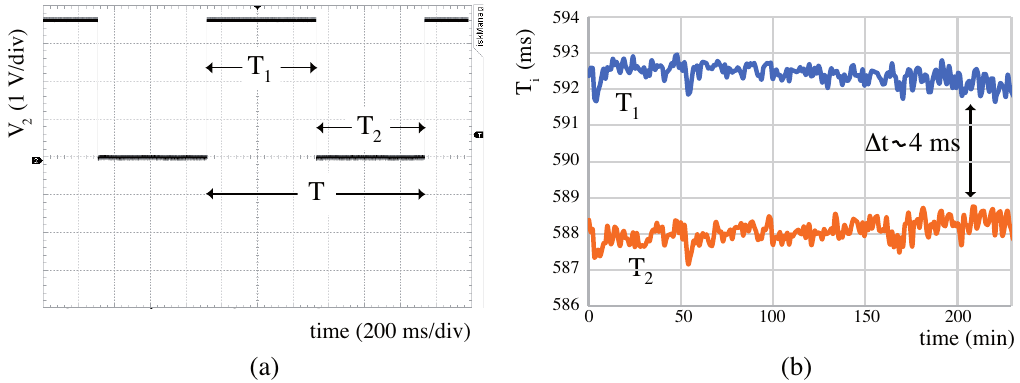
Figure 3. Experimental results for calibrated R sens = 1 G Ω : ( a ) Output voltage V 2 , ( b ) T 1 and T 2 during 200 min.